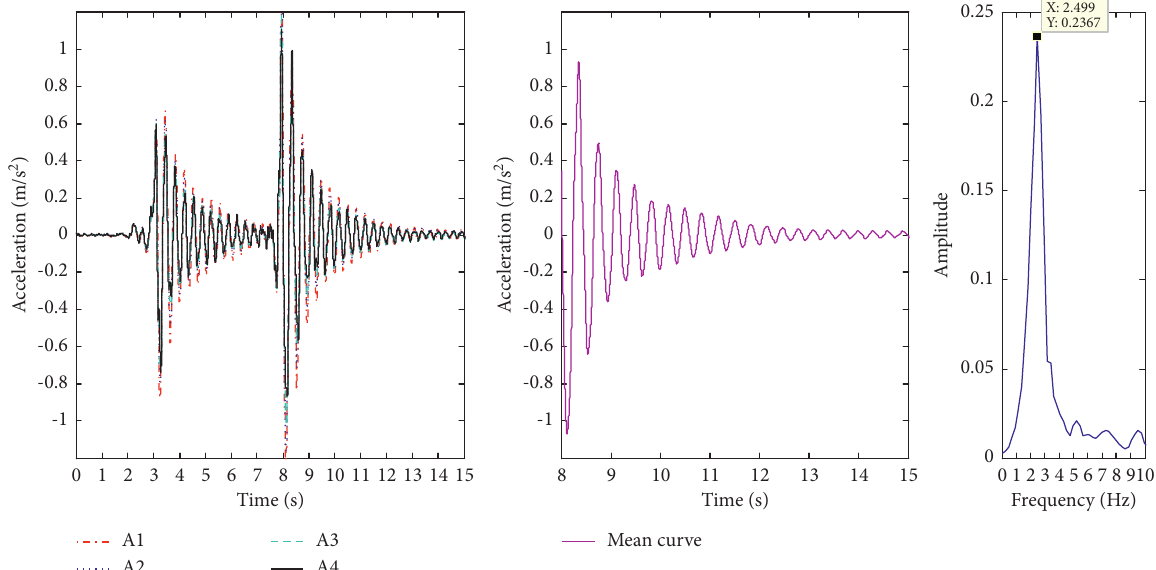
Figure 5: The measured points of time history and frequency domain analysis from free decaying vibration (empty structure).